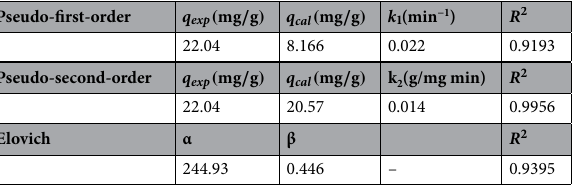
Table 2. Investigation of pseudo-first-order, pseudo-second-order and Elovich parameters in adsorption kinetics.